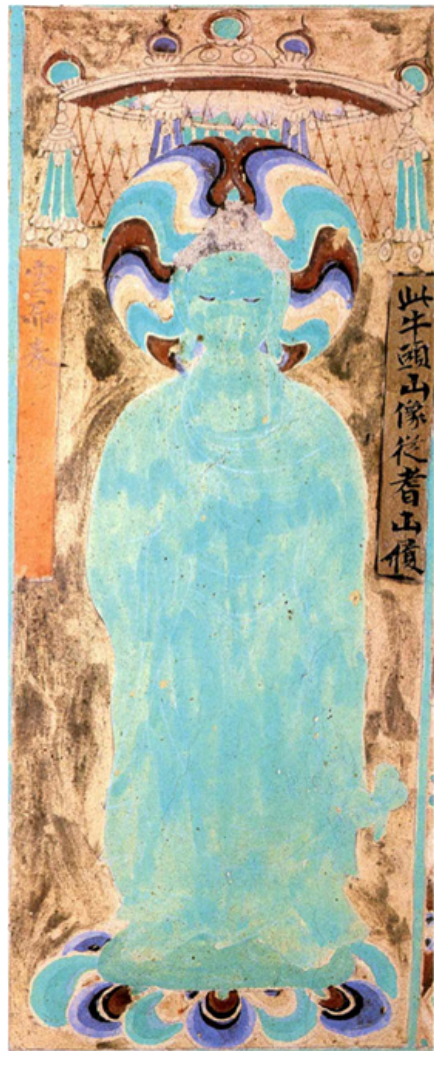
‘High-speed’ transmission to Mt. Niútóu; the caption reads: 此牛頭山像從耆山 [= 闍崛山]履空而來 ‘This image at Mt. Niútóu (Oxhead Mountain) came from Gṛdhrakūṭa (‘Vulture Peak’), it came through treading the air.’ This describes the transmission process and the emplacement of the deity by means of its ‘double’ in the form of a statue. As in the case of many other stories, the emphasis on speed/immediacy is noteworthy. Reproduced from Sūn Xiūshēn 2000, 88,